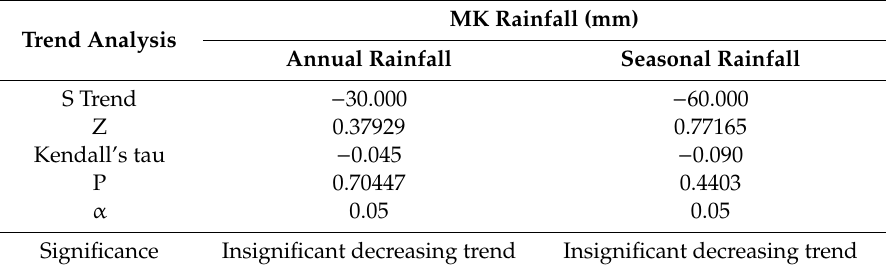
Table 3. Summary of MK results for annual and seasonal rainfalls over Malawi during 1979–2015.